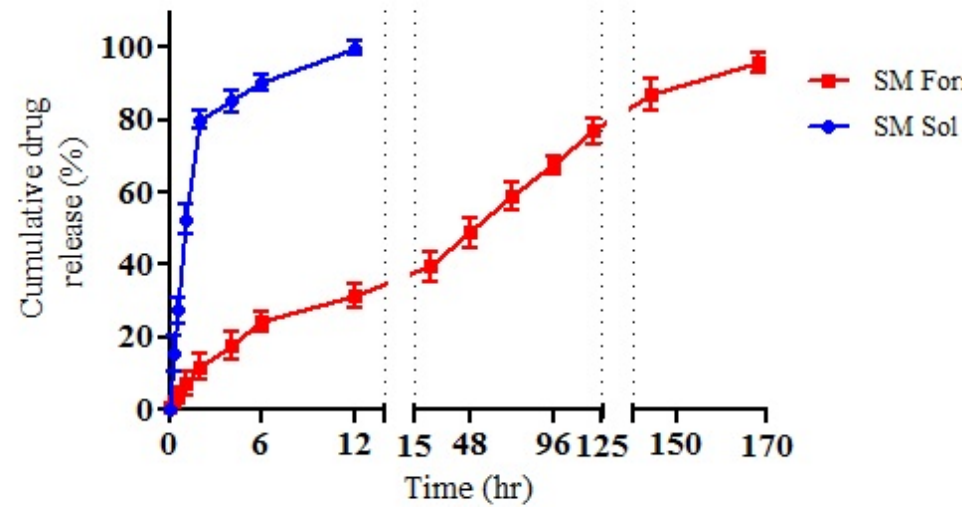
Figure 4. Drug release profile of sunitinib from the sunitinib solution and the SM-MPEG-PCL micelles formulation up to seven days at 37 °C in a phosphate buffer at pH 7.4 (mean ± SD, n = 3). Dotted line represents gap in the continuous axis .